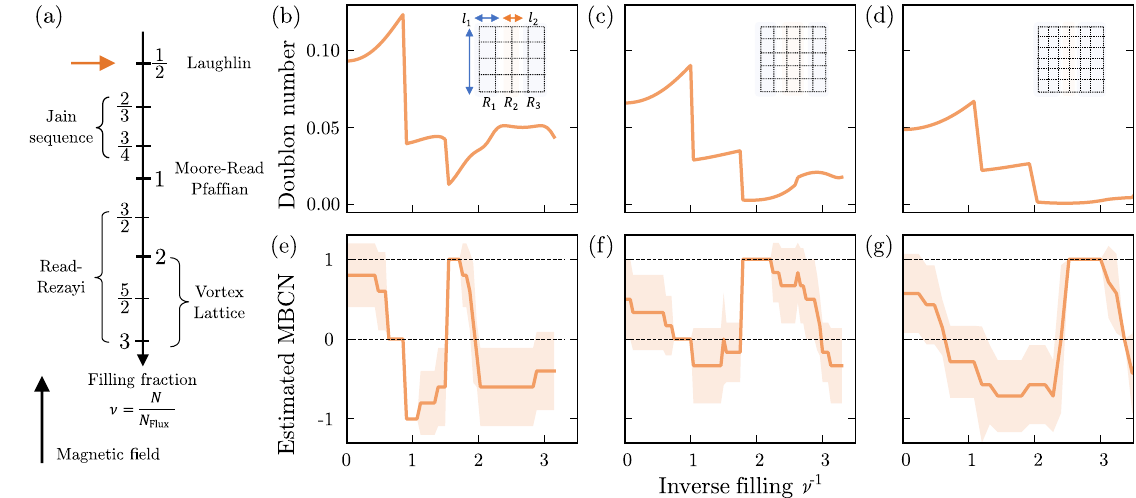
11. (a) Phase diagram of the HBH model conjectured in Ref. [32] as a function of filling fraction ν ¼ N=N . We consider a flux Laughlin state: the ground state of the HBH model with three particles on 36 sites and a flux of α ¼ 0 . 25 π per plaquette, corresponding to a filling ν near 0.5. (b) – (g) Stability of MBCN estimate for the Laughlin state at ν ¼ 1 = 2 . We plot the doublon number (top row) and − 1 Þð L − 1 Þ =N . In each column we indicate estimated MBCN (bottom row) as a function of inverse filling ν − 1 ¼ α ð L x y 5 , (c) L 6 , and (d) L 7 , in each case with N ¼ 3 . At an inverse filling ν − 1 ¼ 2 , the doublon L L L (b) L x ¼ y ¼ x ¼ y ¼ x ¼ y ¼ number abruptly drops, indicating the transition to the Laughlin state. This is accompanied by the estimated MBCN Eq. (G1), with s ¼ 2 jumping to C ¼ 1 (e) – (g). The shaded regions indicate the standard deviation of the estimated MBCN over different choices of subsystems R 1 , R 2 , and R 3 used to evaluate Eq. (G1) indicated in the insets of the top row. We choose the parameter values note that the Laughlin state is particularly numerically stable, with no variation over the parameters l , l 1 , and l 2 y